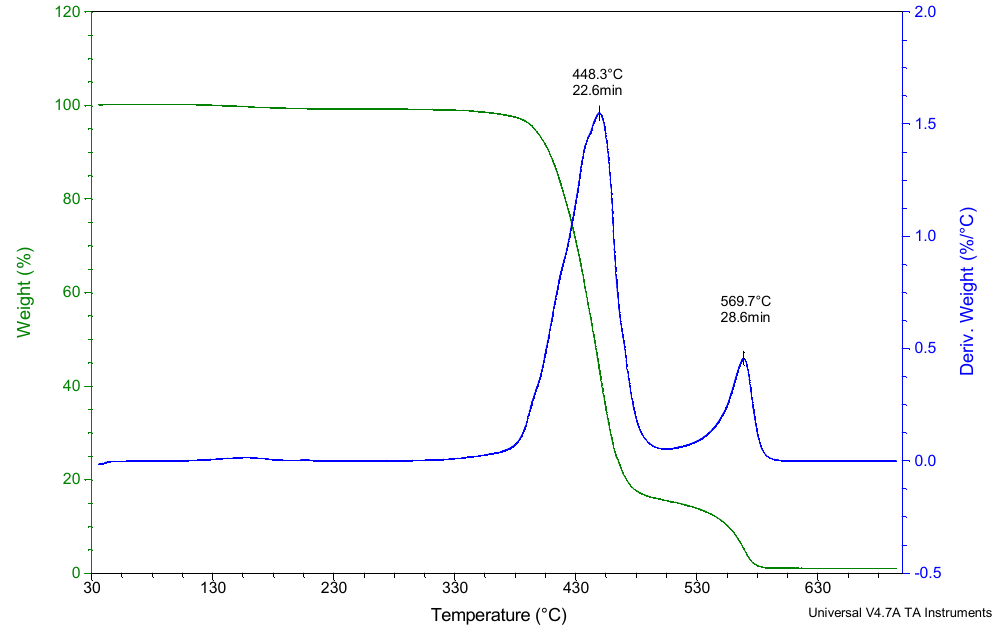
Figure 6. TG and DTG curves of pure PET with marked FTIR analysis points.